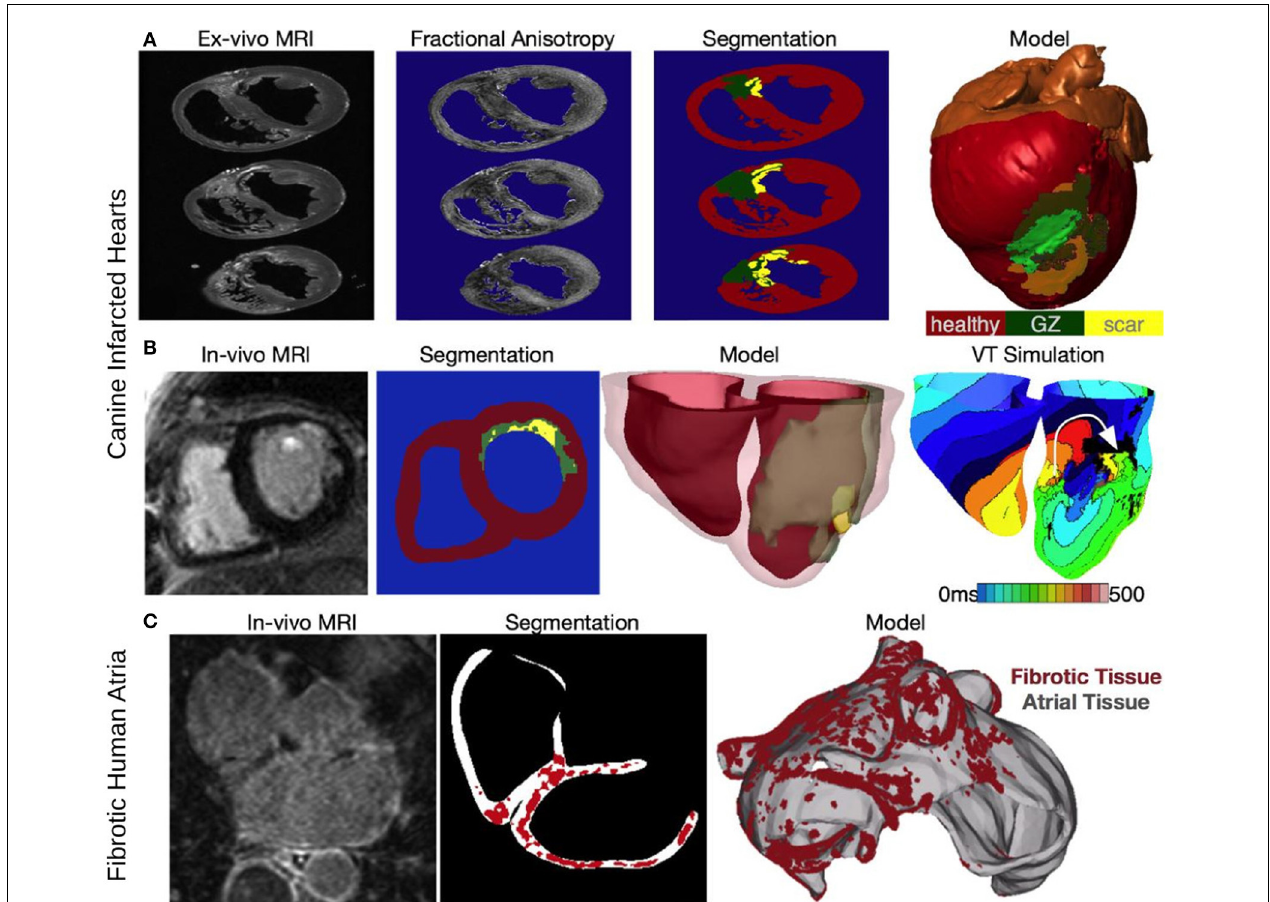
FIGURE 2 | Constructing image-based models of the ventricles from an infarcted canine heart (A,B) and the fibrotic atria of a human patient with AF. (A) Reconstruction from an ex-vivo MRI scan of an infarcted canine heart. Fractional anisotropy (FA) maps as calculated from the DT-MRI, brighter color corresponds with higher FA value. The images are segmented into healthy myocardium, gray zone (GZ), and scar, to reconstruct an image-based model of the infracted canine heart (right-most panel). Modified with permission from Arevalo et al. (2013). (B) Construction of a patient-specific ventricular model of arrhythmia from a clinical MR scan. Shown are images of an infarcted patient heart before ablation (treatment) and the corresponding